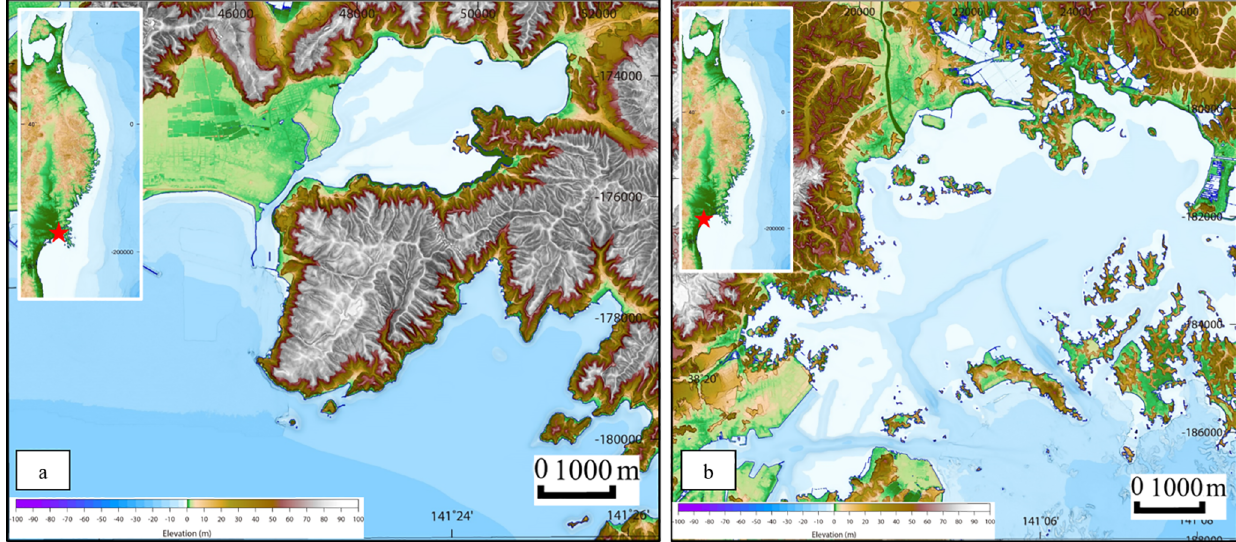
Figure 2. Study areas: (a) Mangokuura Lake and (b) Matsushima Bay.